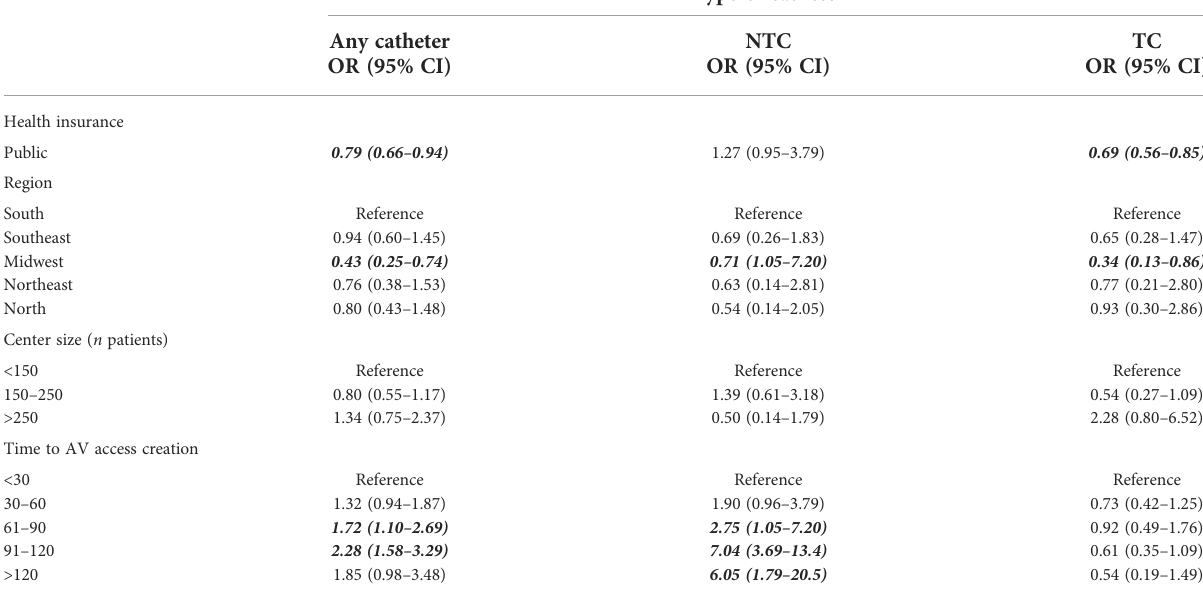
TABLE 7 Model 2 for adjusted multilevel logistic regression for the risk of having a hemodialysis (HD)